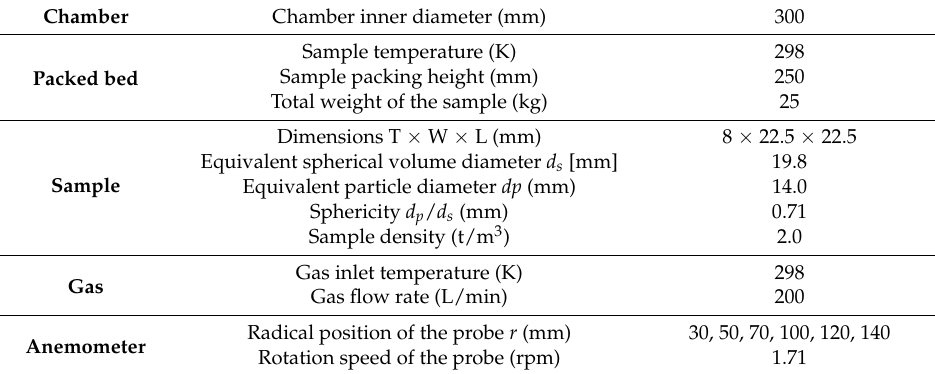
Table 1. Experimental conditions for laboratory-scale gas velocity